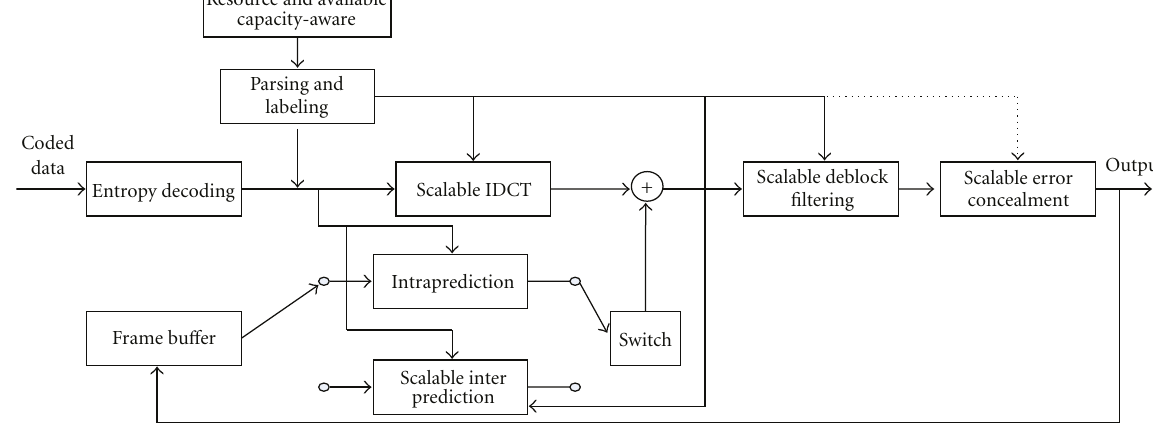
Figure 3: Illustration of the power scalable control video decoding